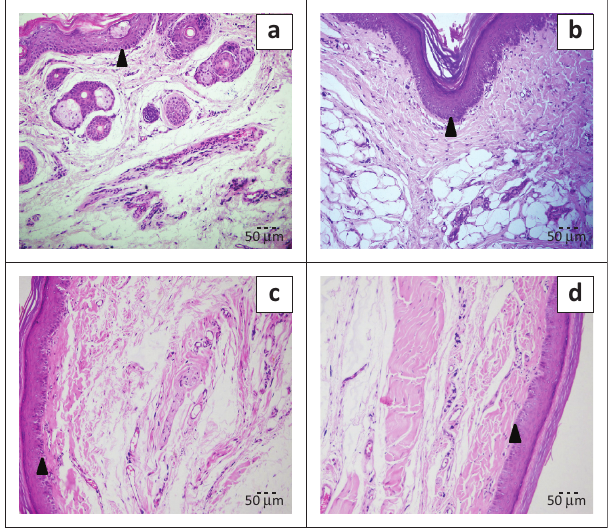
FIGURE 5: Bedding-change frequency (twice per week): Degenerative changes (arrow head) and acantholysis (arrow) in epithelial cells, H&E, (a) perlite, (severe), (b) wood shavings-perlite (moderate), (c) wood shavings (mild) and (d) corncob (mild).